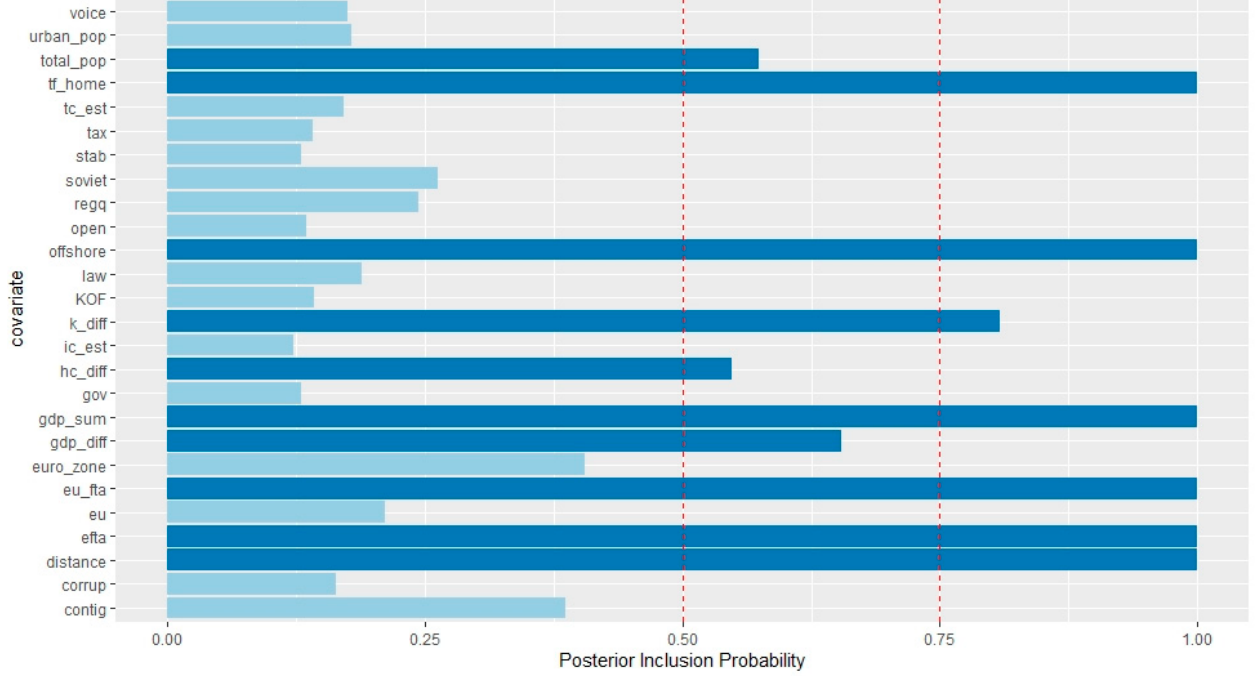
Figure 1. Inclusion probabilities for each of the potential covariates for Estonia, general case (2004–2017).